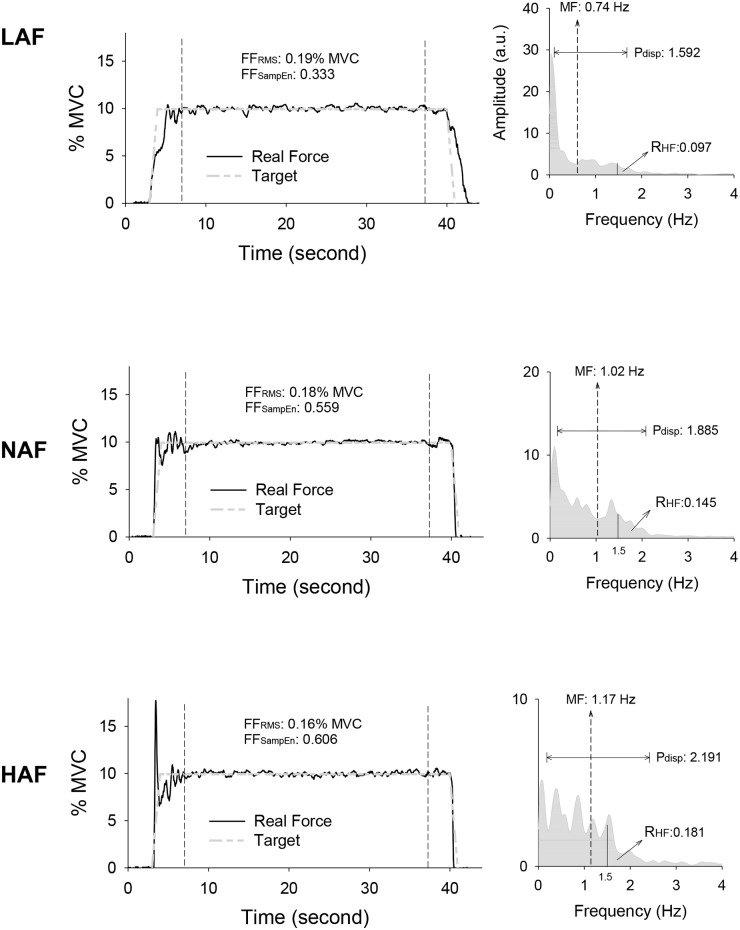
Representative trials of force data (left plots) and pooled power spectra (right plots) of force fluctuations in the time window of interest from a typical participant for the low amplification (LAF), normal amplification (NAF), and high amplification (HAF) conditions.FFRMS: root mean square value of force fluctuations, FFSampEn: Sample entropy of force fluctuations, MF: mean frequency, Pdisp: power dispersion of force fluctuations, RHF: ratio of high frequency components in force fluctuations.